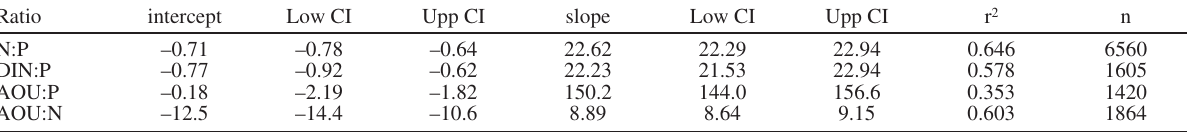
Fig. 6. – Seasonal stoichiometry depth profiles of N:P (A), dissolved inorganic nitrogen (DIN=NO open sea stations (bottom depth>200 m) of the Catalan Sea. The first 200 m are enlarged in the small plots. Table 4. – Results of the standard major axis regressions of nitrate (N), dissolved inorganic nitrogen (DIN) and apparent oxygen utilization (AOU) vs. phosphate (P), and AOU vs. nitrate in the Catalan Sea. Shown are the y-intercept and the slope of the regression equations, the interval of confidence (Low CI and Upp CI), the coefficient of determination (r 2 ), and the number of data points included (n). All slopes and intercepts, except the AOU:P intercept, are significantly different from 0 (p ≤ 0.001). Ratio intercept Low CI Upp CI slope Low CI Upp CI r 2 n